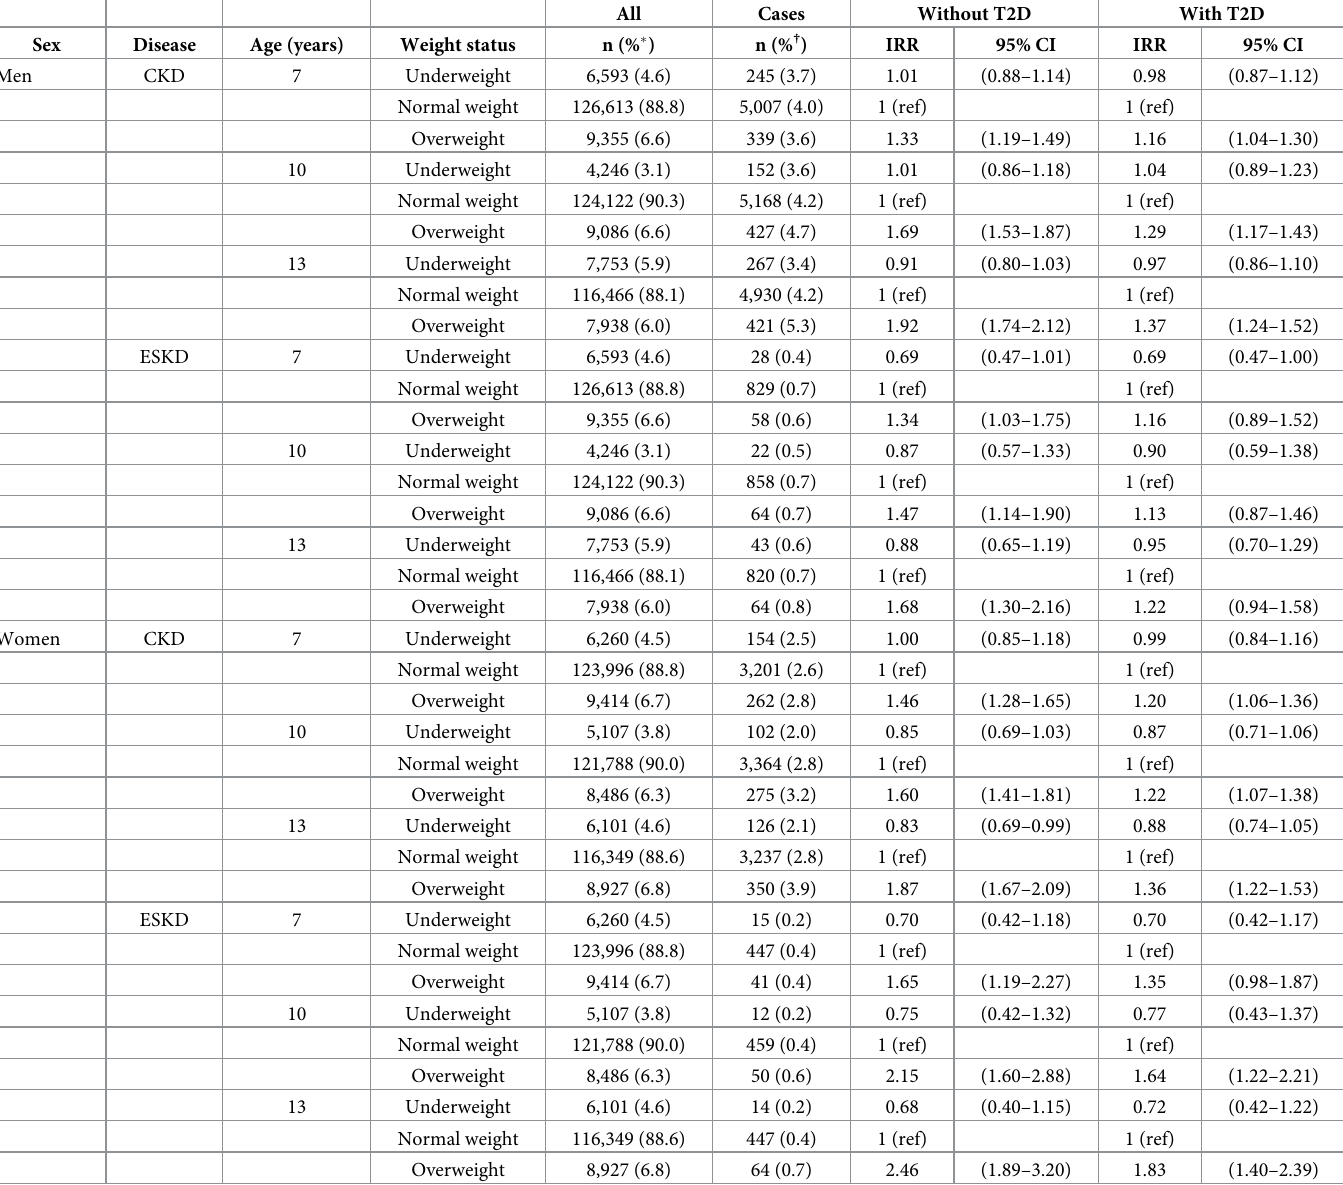
Table 3. Childhood weight status and CKD and ESKD. Sex-specific IRRs and corresponding 95% CIs of the associations between childhood weight status at ages 7, 10, and 13 years and CKD and ESKD, respectively, in analyses with and without adult-onset T2D and duration with